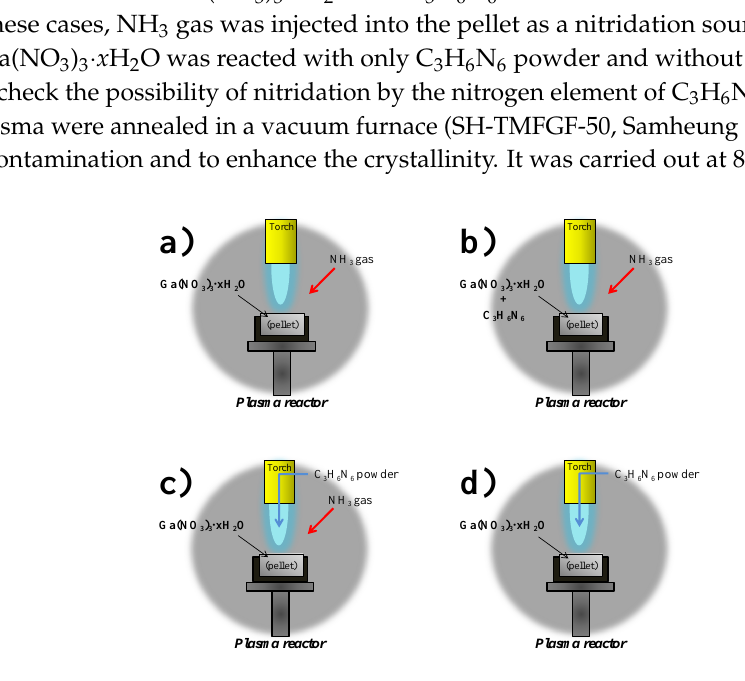
Figure 2. Detailed illustration of C 3 H 6 N 6 injection methods in Plasma 1, 2, 3, 4, and 5; ( a ) Plasma 1; ( b ) Plasma 2; ( c ) Plasmas 3 and 4; ( d ) Plasma